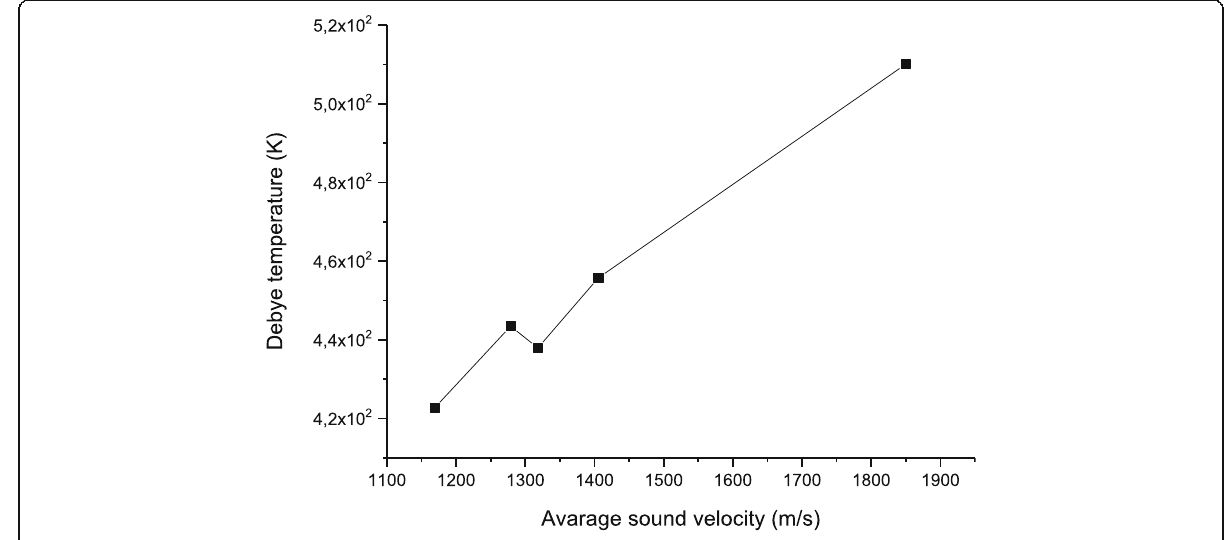
Fig. 3 Variation of the Debye temperature with varying average sound velocity